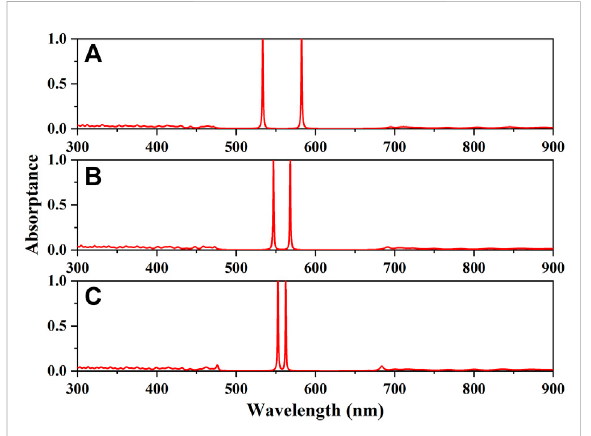
FIGURE 7 Absorption spectra of the PC (AB) 5 D(BA) N D(AB) 20 with d D = 128.5 nm and k D = 0.0036. (A) N = 2. (B) N = 4. (C) N = 6.